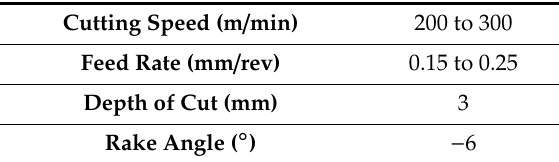
Table 1. Cutting parameters.